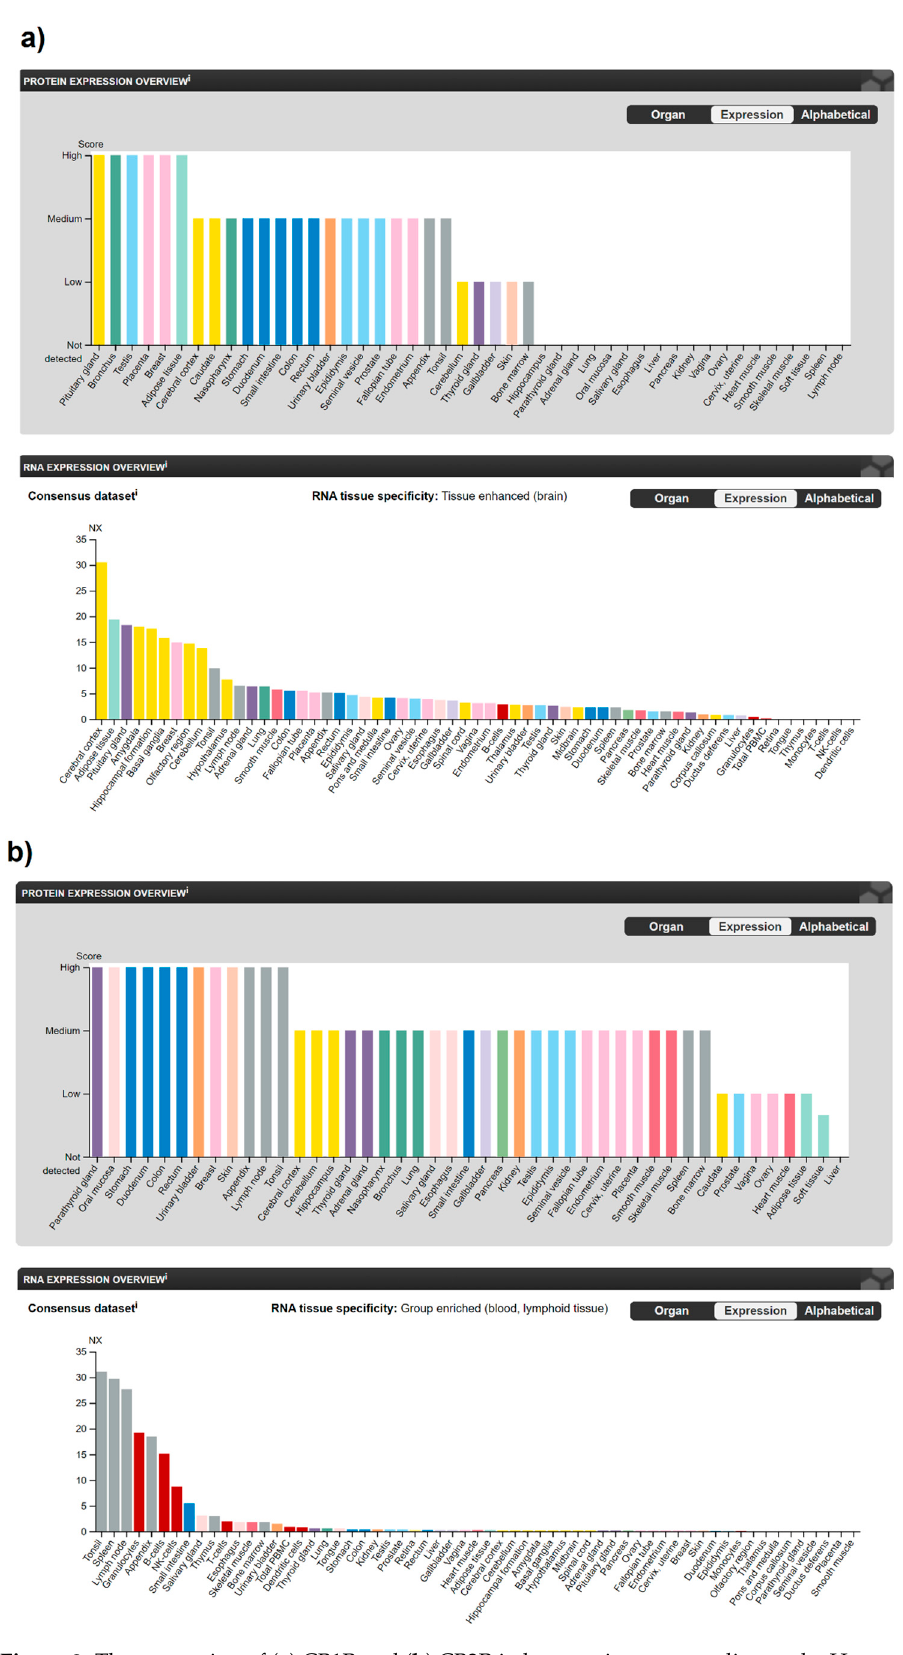
Figure 2. The expression of ( a ) CB1R and ( b ) CB2R in human tissues according to the Human Protein Atlas database [10]. mRNA expression overview shows RNA as the consensus dataset based on a combination of three sources—RNA-sequencing data from internally generated Human Protein Atlas (HPA), RNA-sequencing data from the Genotype-Tissue Expression (GTEx) project and Cap